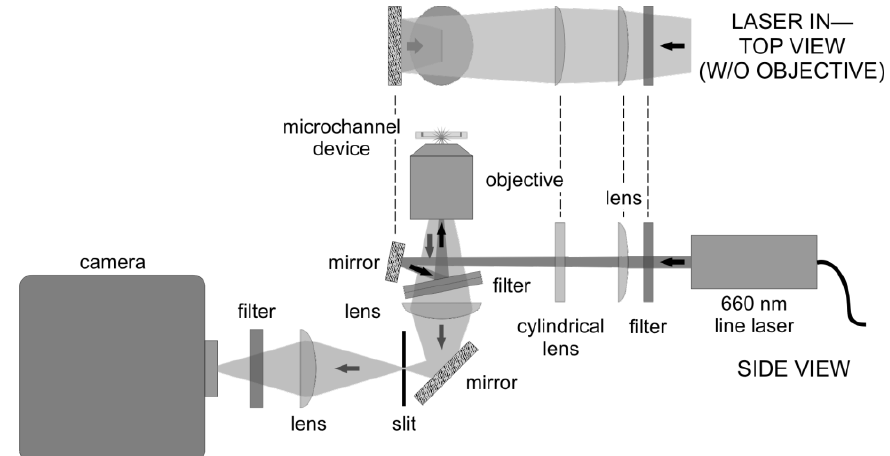
Figure 3. Schematic of the custom wide-field microscope.